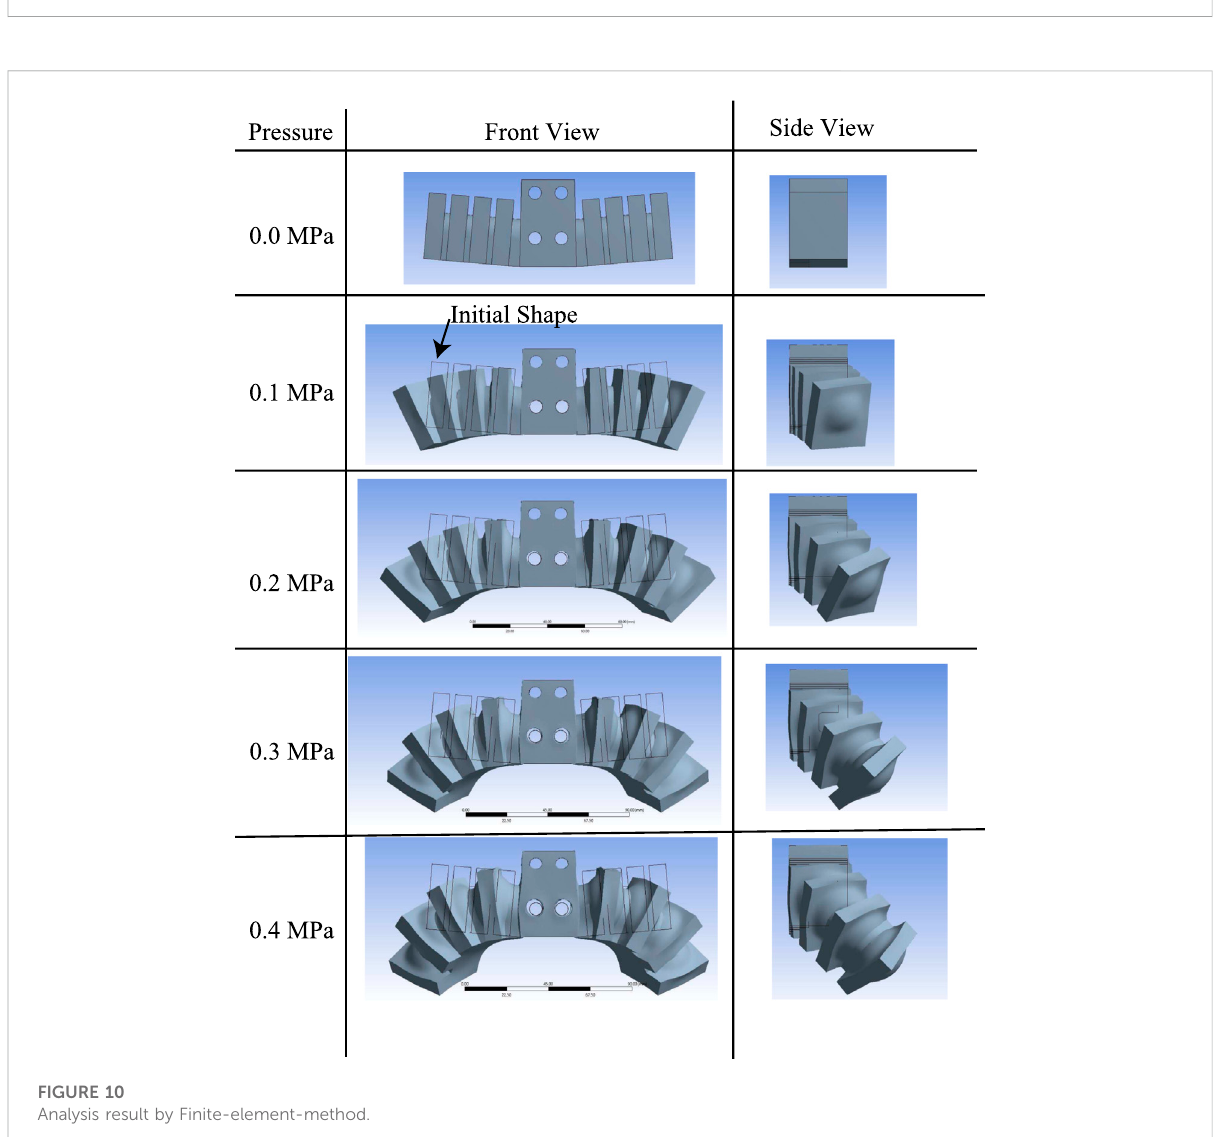
FIGURE 10 Analysis result by